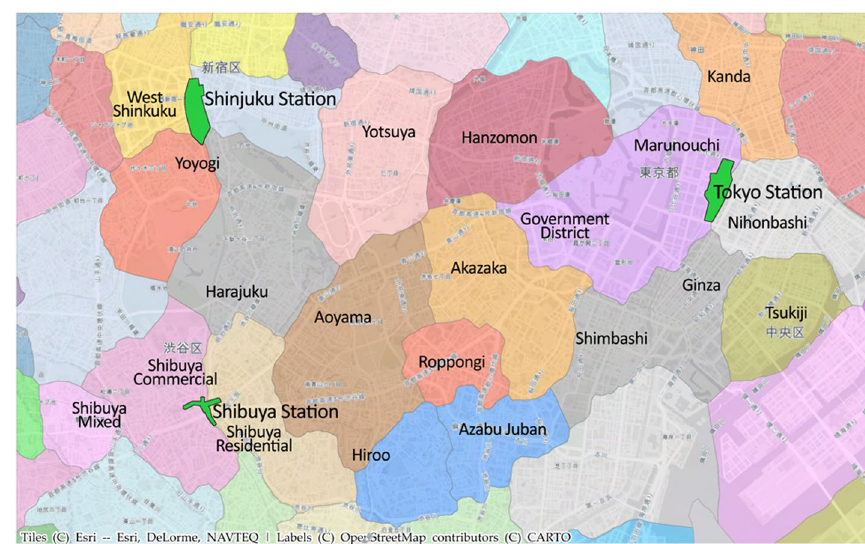
Fig. 11 Close-up map of the communities discovered using the greedy modularity using ω 1 edge weights based on road features for 200 m